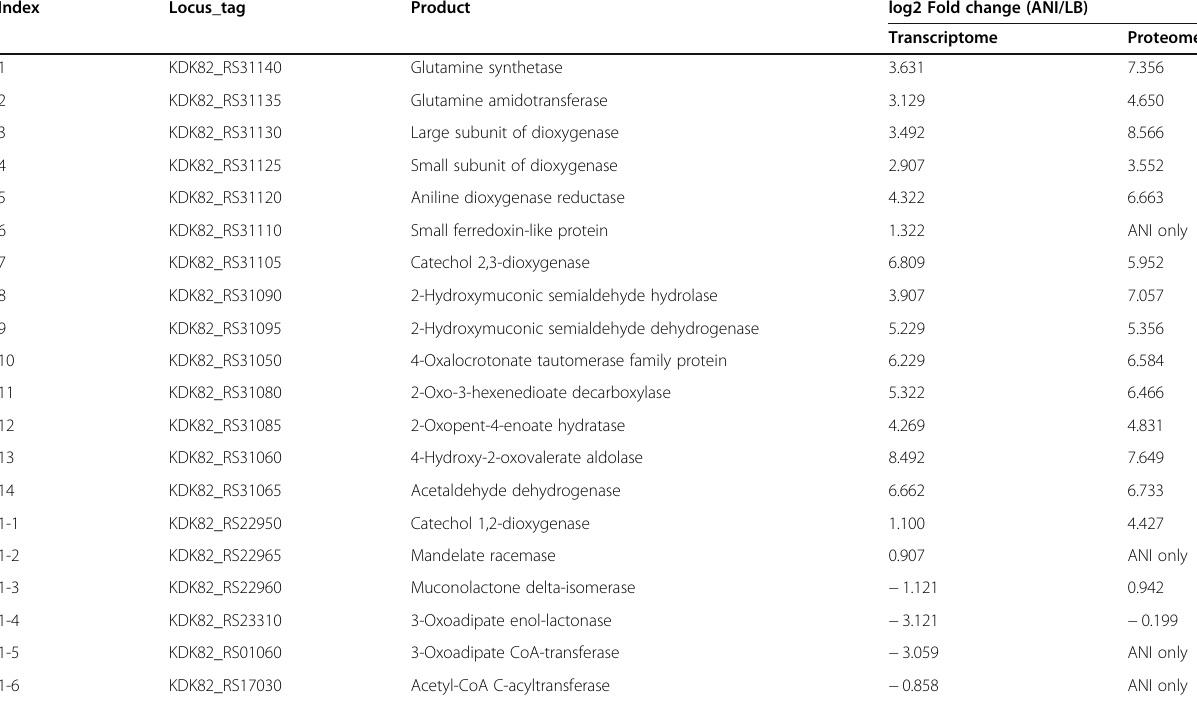
Table 3 Results of multi-omics analysis of aniline degradation pathway in Delftia sp.